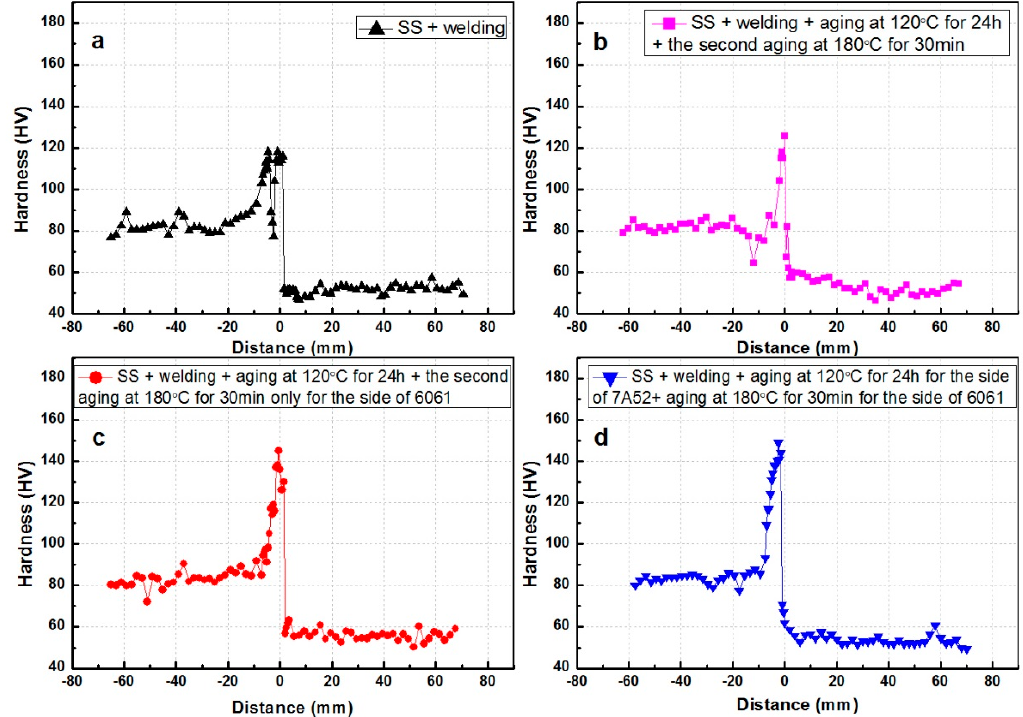
Figure 3. Microhardness profile along the middle section of the weld joint of 7A52 and 6061 Al alloys with pre-solid-solution and different post-aging.